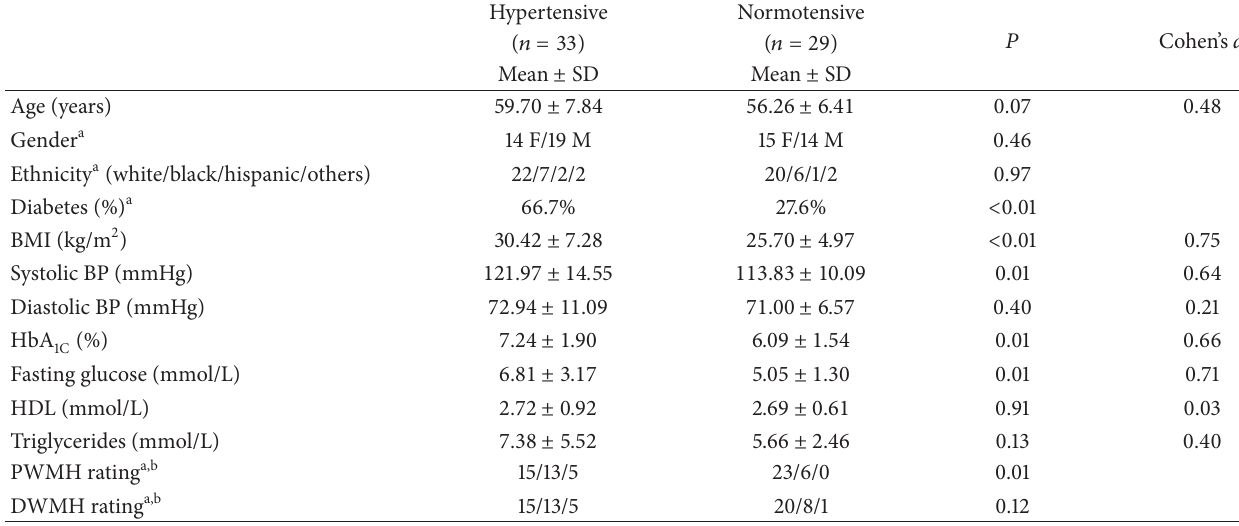
Table 1: Demographic and endocrine data: hypertensive versus